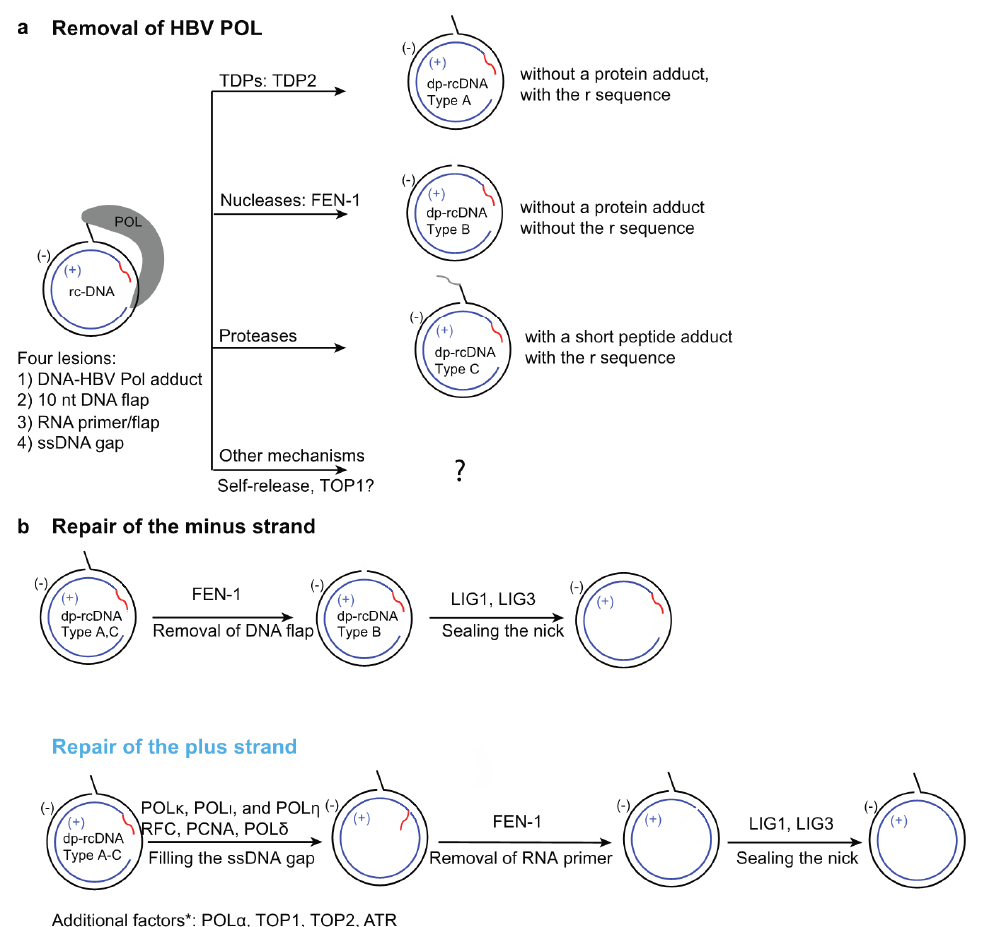
Figure 2. The repair factors and steps involved in conversion of HBV rcDNA to cccDNA. ( a ) Removal of HBV polymerase (POL) adduct from rcDNA can be achieved by: (1) tyrosylphosphodiesterases (TDPs), such as TDP2; (2) nucleases, such as FEN-1; (3) proteases; and (4) other mechanism such as self-release of POL, or TOP1 mediated release. The first three mechanisms will lead to formation of types A−C of deproteinated rcDNA (dp-rcDNA). Type A and C dp-rcDNAs contain the terminal redundancy DNA flap, whereas type B dp-rcDNA does not. The repair intermediates of POL self-release or TOP1-mediated release are not clear and are thus denoted by a question mark. ( b ) After the removal of POL, the minus strand is further repaired by removal of the terminal redundancy DNA flap via FEN-1 or other nucleases and ligation of the nick by LIG1 or LIG3. The steps involved in repair of the plus strand are: (1) completion of DNA synthesis by various host DNA polymerases; (2) removal of the displaced RNA primer via FEN-1; and (3) ligation of the nick by LIG1 and LIG3. Additional factors POLα, TOP1, and TOP2 are shown to be involved in cccDNA formation; however, it is not clear which steps they are involved in. ATR has been shown to be involved in preventing the degradation of the minus stand. Red wavy line, RNA primer; gray wavy line, remnant peptide post protease digestion.